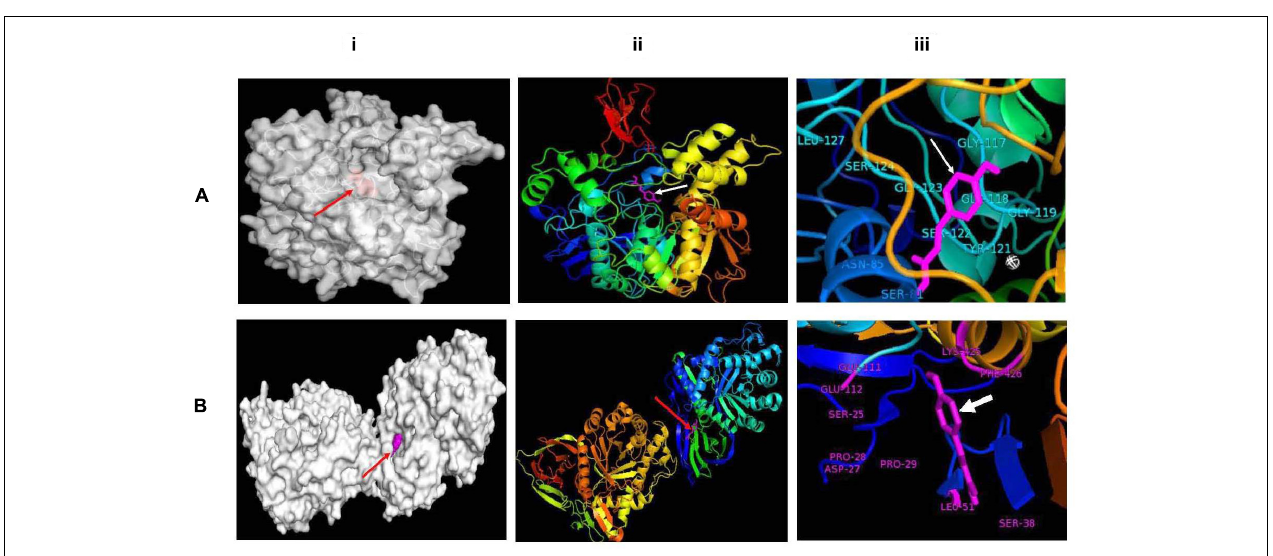
FIGURE 3 | | Molecular docking between p-coumaric acid with acetylcholine esterase (A) and β -glucosidase (B) . Docked proteins have been shown as gray surface models (i); proteins have been visualized as ribbons docked with p-coumaric acid (stick, magenta) (ii); and docked p-coumaric acid (stick, magenta) at the active sites of proteins